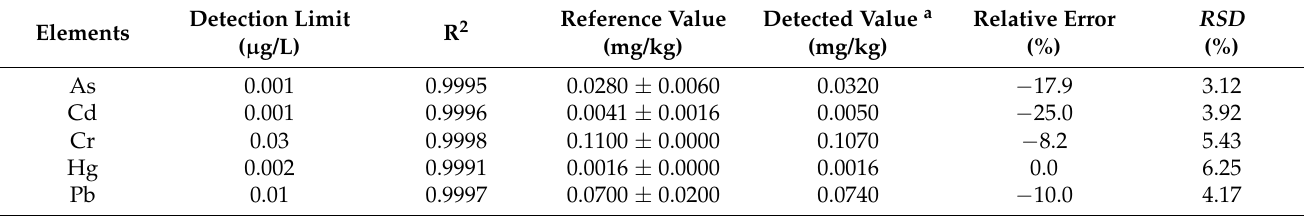
Table 1. The validation parameters of the analytical method of heavy